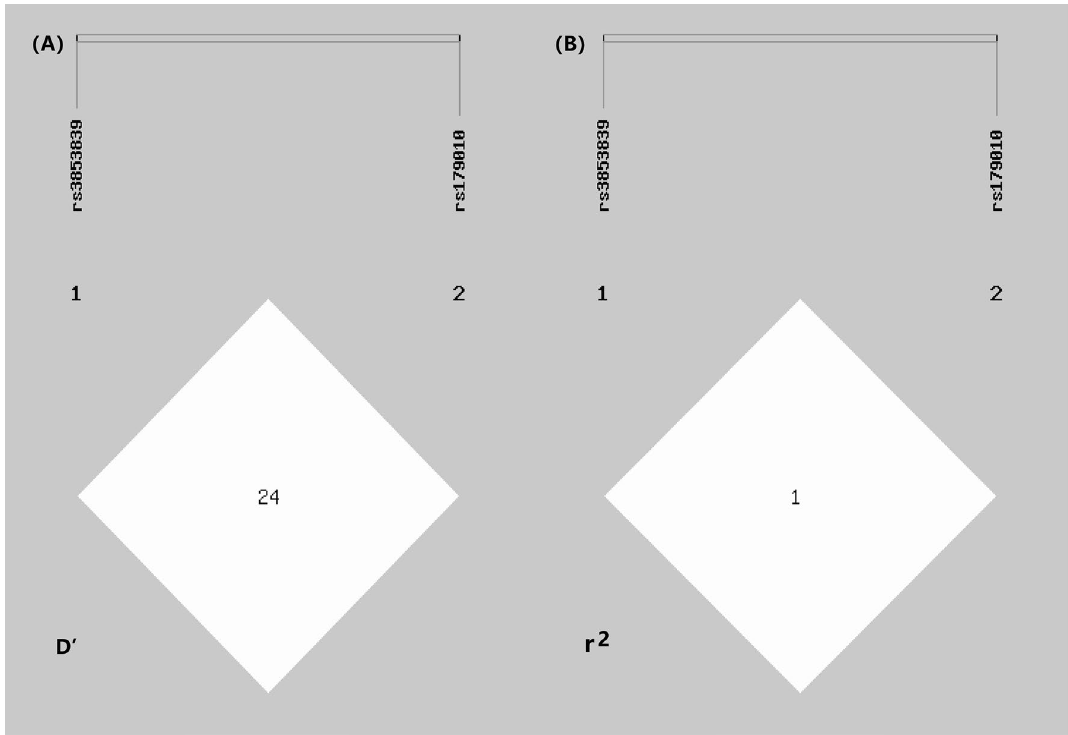
Figure 1. Linkage disequilibrium (LD) patterns in TLR7. D’ ( A ) and r 2 ( B ) mean LD coefficients of the two SNPs. Each block represents the LD relationship between two SNPs. Rs3853839 indicated no LD with rs179010.